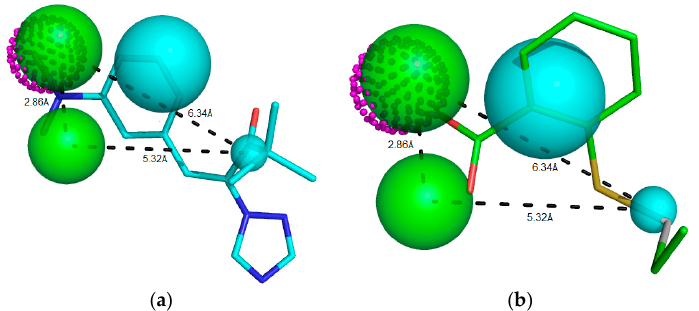
Figure 4. Potent RIPK2 inhibitor ( a ) IC 50 = 0.90 µ M, Mol_qry value = 51.35; and ( b ) weak RIPK2 inhibitor IC 50 = 1.40 μ M, Mol_qry value = 04.10 superimposed to the pharmacophoric Model 05, where green beads/spheres represents Hbond acceptor groups, magenta doted sphere represents Hbond donor